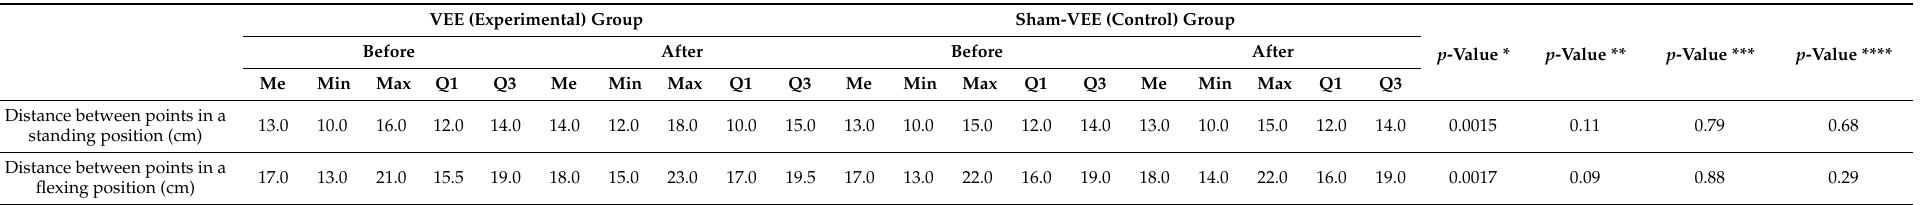
Table 3. Intragroup and intergroup comparisons of the changes in lumbar ROM measured by Schober’s test before and after the PA intervention (cm). VEE (Experimental) Group Sham-VEE (Control) Group